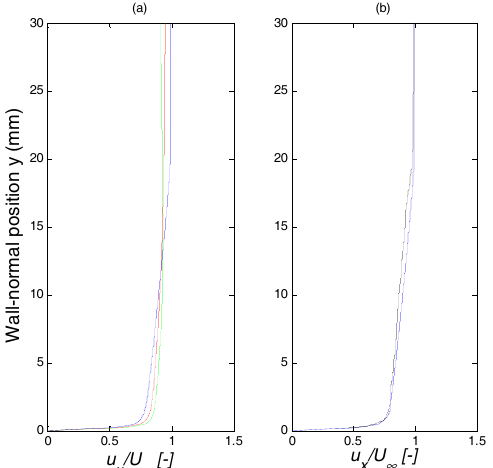
Figure 6. Comparison of the normalized streamwise velocity profile at the 10H downstream plane position and spanwise position of z = 0 corresponding to the baseline case of H = 5 mm. ( a ) CFD curves for three different meshes: coarse (green), medium (red) and fine (blue); ( b ) Boundary layer (BL) velocity profiles of the fine mesh (blue) versus the experimental one (black).